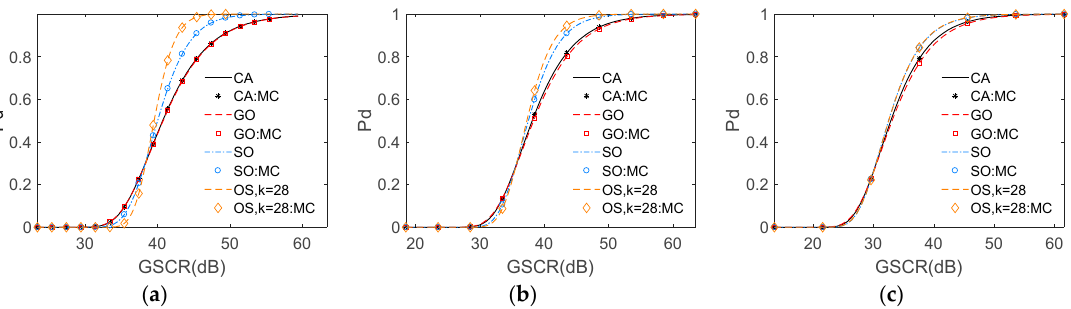
Figure 4. The probability of detection (Pd) of different detectors versus the generalized signal-to-clutter ratio (GSCR). The parameters N = 32, γ = 1 and designed Pfa = 10 − 4 . ( a ) α = 0.2 (MRE (%): CA: 0.0054; GO: 0.0072; SO: 0.0032; OS ( k = 28): 0.0063) ( b ) (MRE (%): CA: 0.0028; GO: 0.0031; SO: 0.0025; OS ( k = 28): 0.0023) ( c ) α = 0.8 (MRE (%): CA: 0.0076; GO: 0.0081; SO: 0.0026, OS ( k = 28):